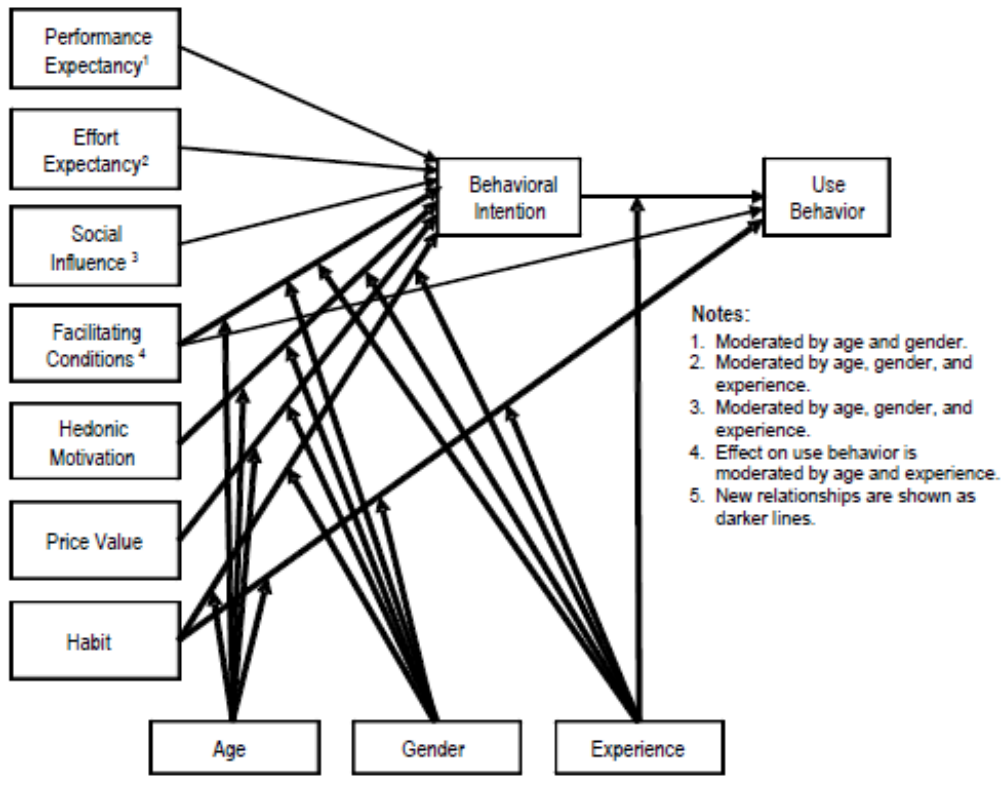
Figure 1 . The UTAUT model. Source: Venkatesh et al., 2012